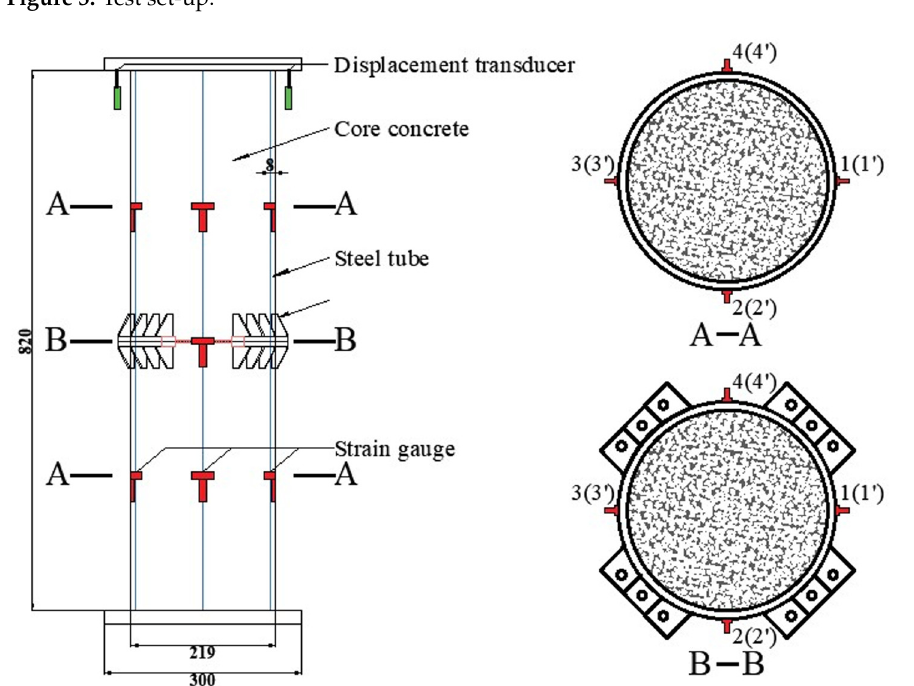
Figure 4. Measurement scheme.